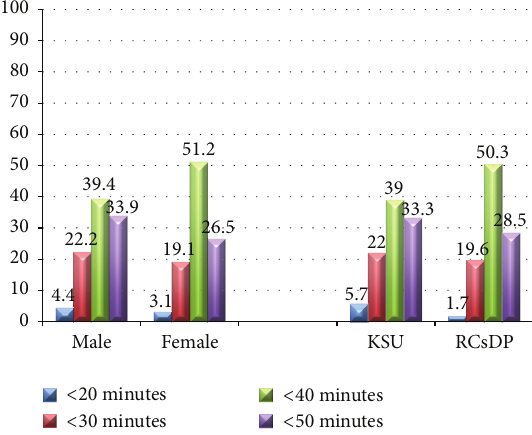
Figure 1: Percentage of dental students’ preferences regarding lecture length.